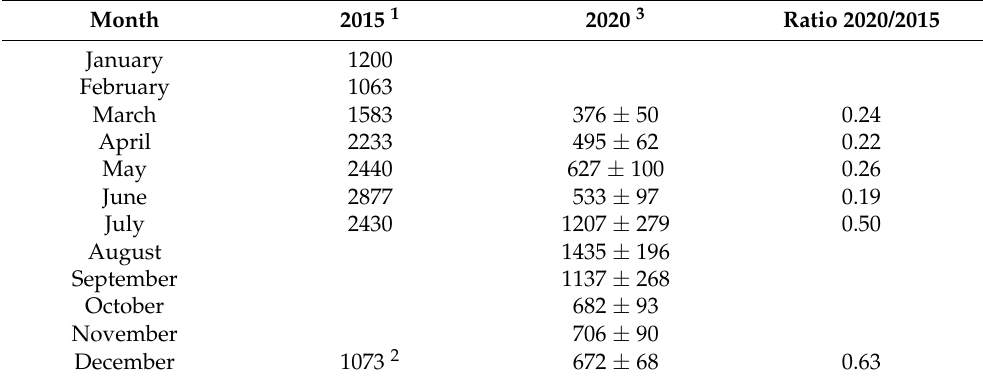
Table 2. Comparison of ambient BC measurements in east Santiago, monthly averages (ng/m 3 ).